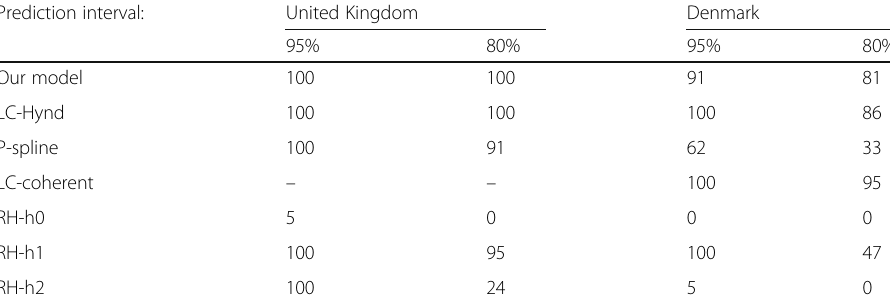
Table 1 Empirical frequencies to assess calibration of prediction intervals in the validating mortality forecasts for British and Danish women Prediction interval: United Kingdom Denmark